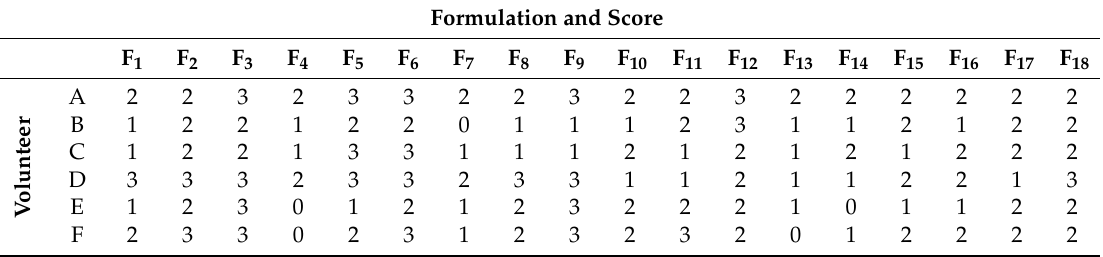
Table 5. Sensory evaluation of microparticles obtained with organic EC solution (formulations F 1 –F 9) and with MN addition (formulations F 10 -F 18 ), scored as follows: 0—not bitter, 1—slightly bitter, 2—moderately bitter, 3—very bitter.